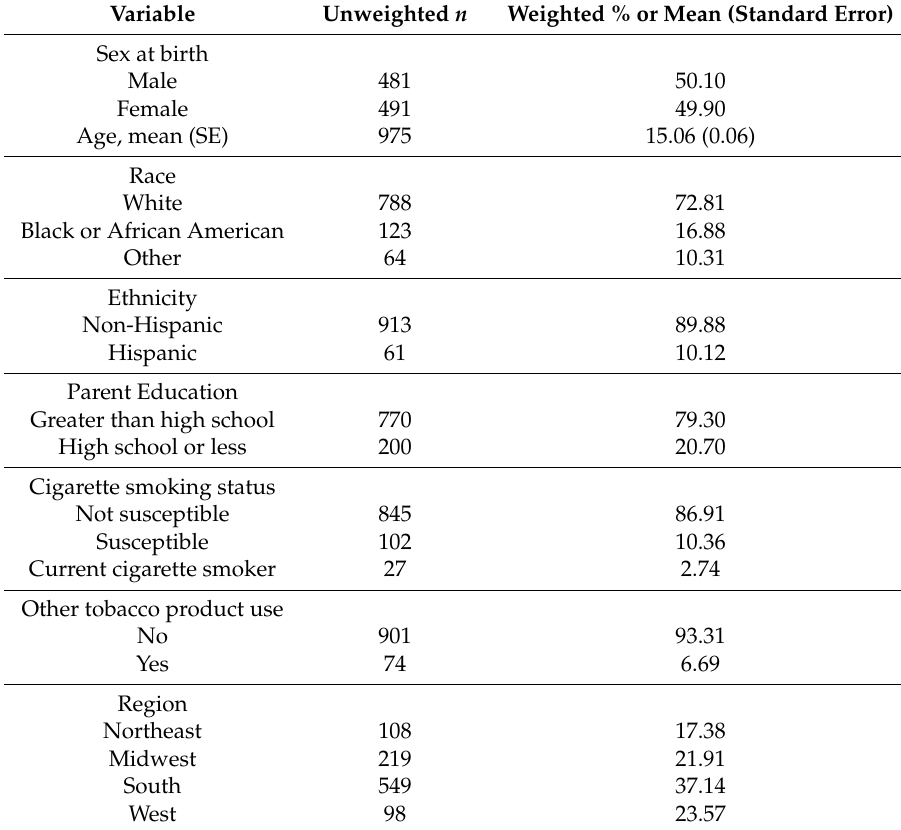
Table 1. Participant characteristics from a national sample of adolescents, conducted by the Carolina Survey Research Laboratory from August 2016 to May 2017, n =